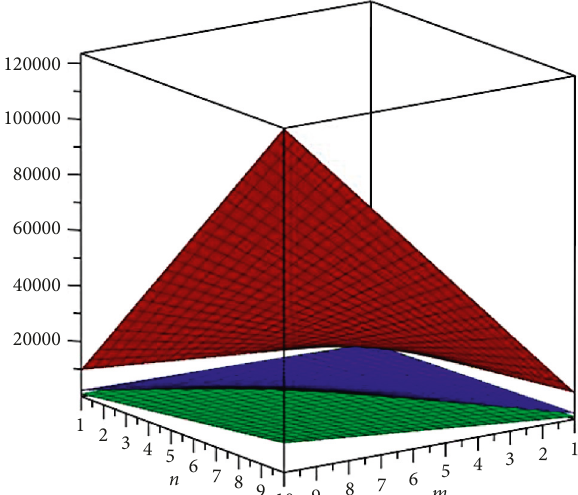
Figure 3: Graphical depiction of Table 3.